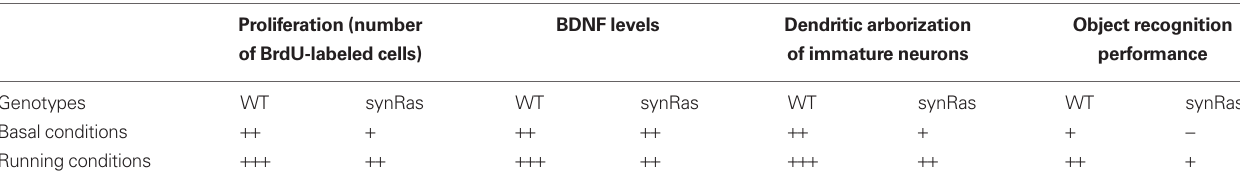
Table 1 | Main results at a glance (Lafenetre et al.,